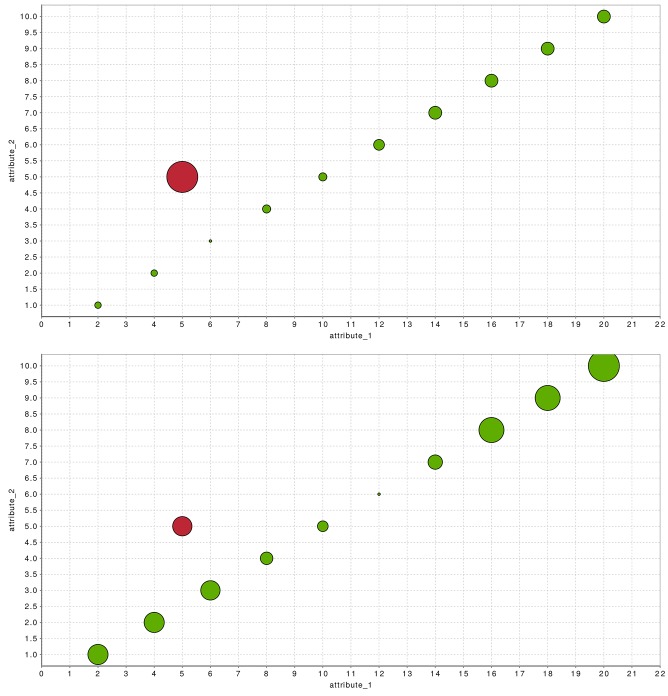
Comparing COF (top) with LOF (bottom) using a simple dataset with a linear correlation of two attributes.It can be seen that the spherical density estimation of LOF fails to recognize the anomaly, whereas COF detects the non-linear anomaly (k = 4).